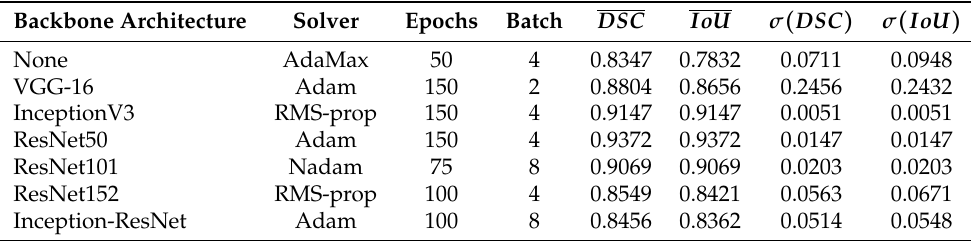
Table 8. Results achieved with images in the axial